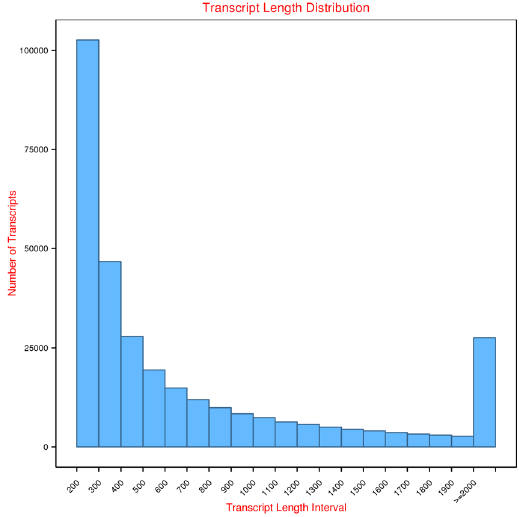
Figure 1. Sequence length distribution of transcripts and unigenes assembled from Illumina reads of the gill transcriptome of Ruditapes philippinarum . The x-axis indicates the lengths of the transcripts and unigenes, and the y-axis indicates the number of transcripts and unigenes in each size